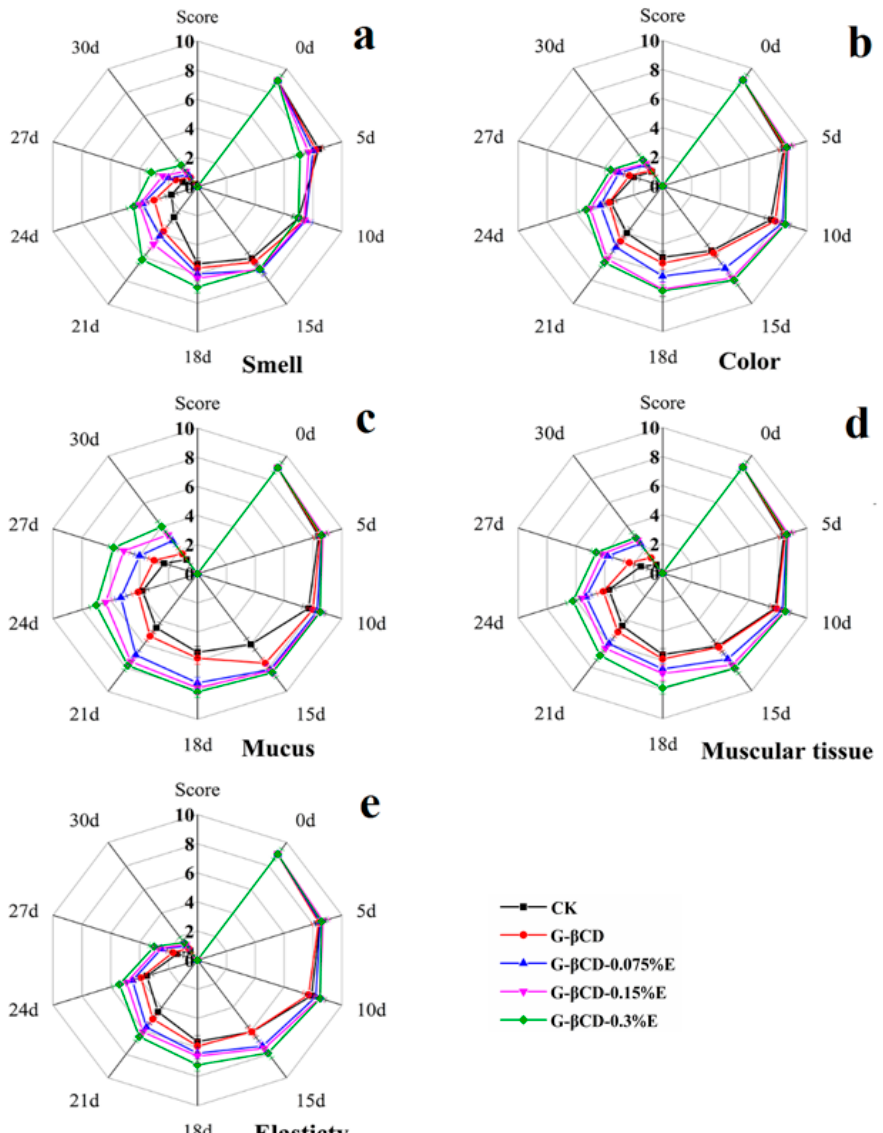
Figure 4. Changes in organoleptic properties results (smell: a ; color: b ; mucus: c ; muscular tissue: d ; elasticty: e ) of Chinese seabass during superchilling storage at − 0.9 °C. (CK: uncoated; G- β CD: gelatin- β -cyclodextrin coating without eugenol; G- β CD-0.0%75E: gelatin- β -cyclodextrin coating with 0.075%eugenol; G- β CD-0.15%E: gelatin- β -cyclodextrin coating with 0.15% μ L mL − 1 eugenol; G- β CD-0.3%E: gelatin- β -cyclodextrin coating with 0.3% eugenol).